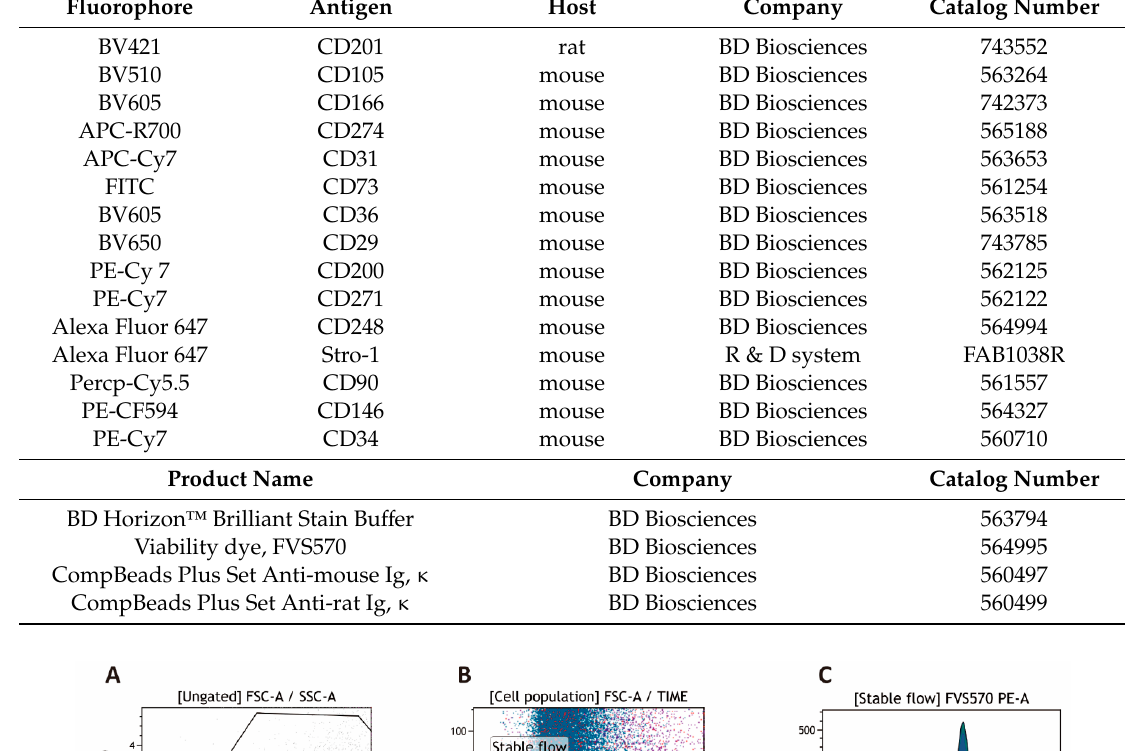
Table A1. Technical details on antibodies and reagents used for flow cytometry.